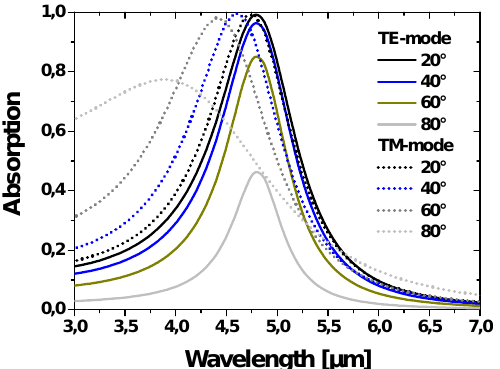
Figure 4. Absorption properties for TE and TM polarization at oblique angle of light